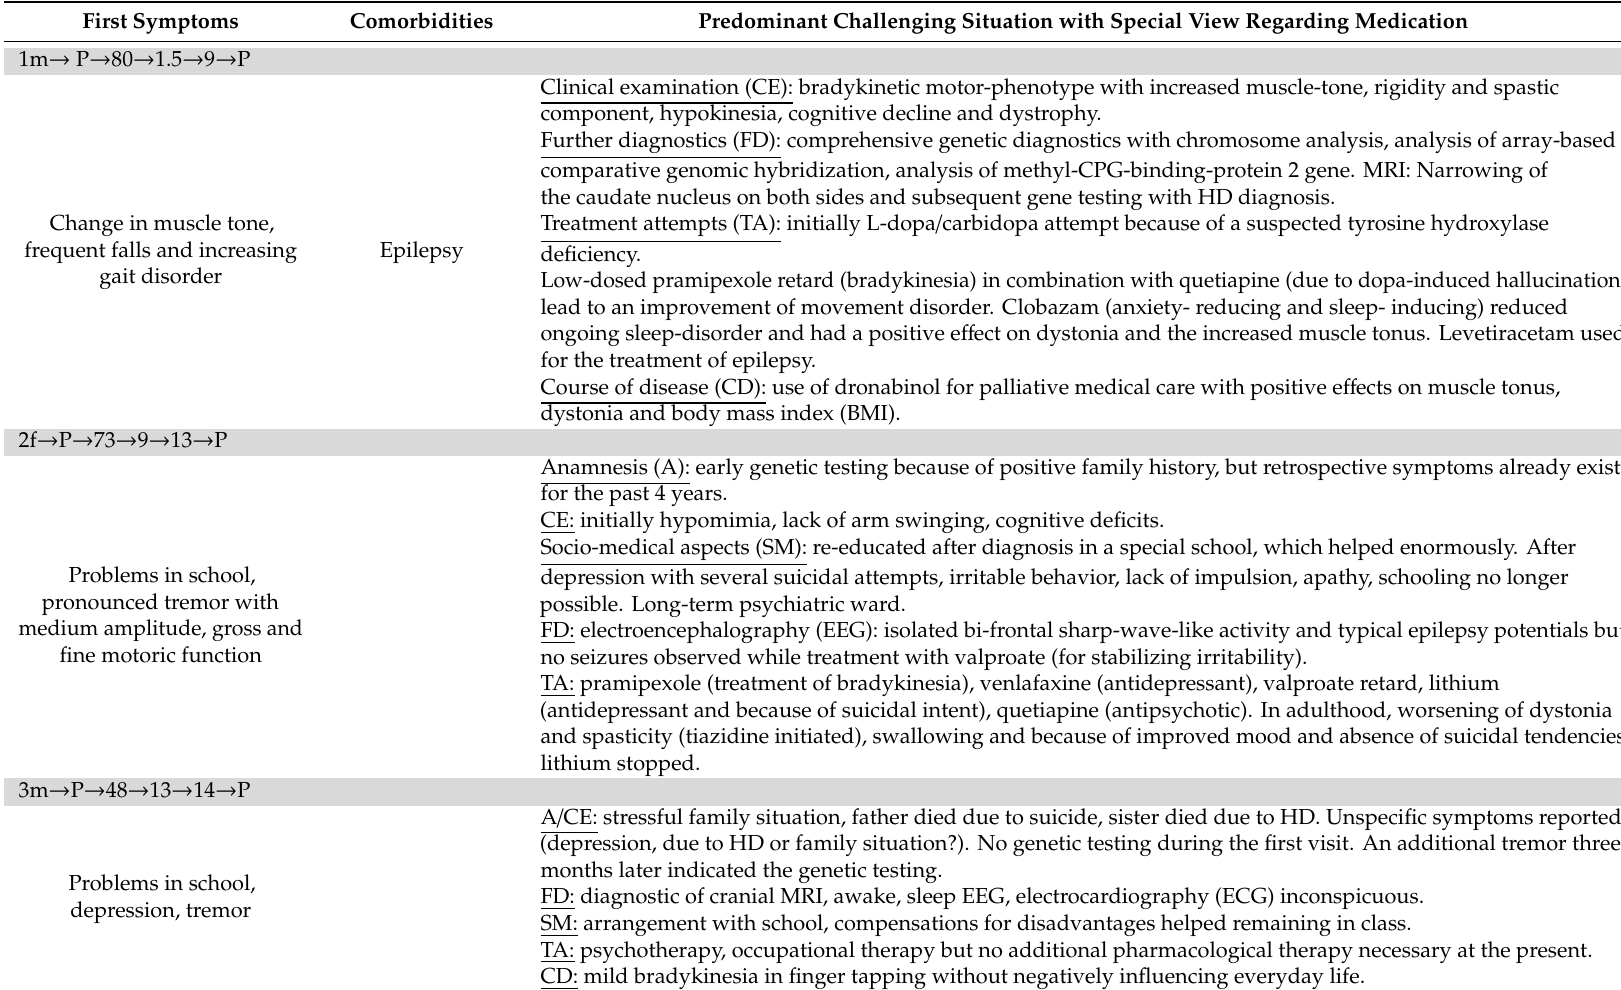
Table 1. Clinical characteristics and relevant findings of juvenile and / or pediatric Huntington’s disease (HD) cases from the Huntington Centre, North Rhine-Westphalia